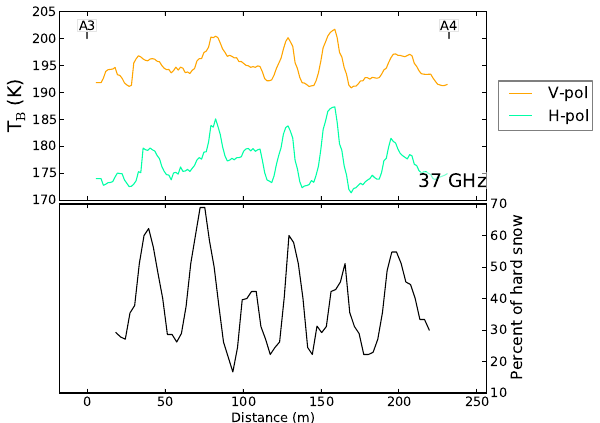
Figure 9. Hardness tested manually along the A3–A4 transect as a function of distance. The penetration in the top 30cm of the snow- pack was tested using a stick with a 10mm diameter. The percent of hard snow was calculated by accounting for all these tests in a window (30m cross-track by 12m along track) moving along the